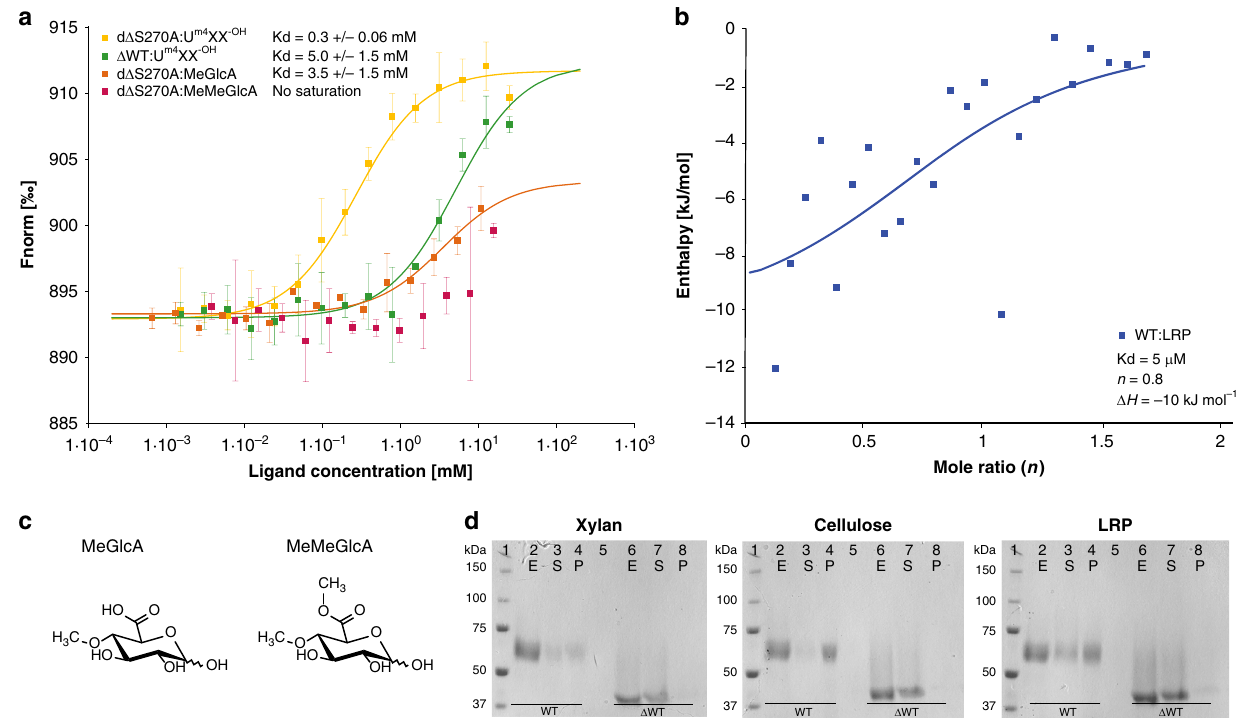
Fig. 5 Af fi nity for natural substrates or derived soluble fragments. a Ligand-binding af fi nities of soluble ligands to various Cu GE variants as determined by LabelFree microscale thermophoresis (MST). Legend details and estimated K d -values are listed in the panel and error bars represents standard deviation. b ITC enthalpogram of the interaction between WT Cu GE and the enzyme ’ s natural insoluble lignin-rich substrate (LRP) at 5 °C. The titration curve is depicted as a function of the molar ratio ( n ) between enzyme and the calculated concentration of 4- O -methyl-glucuronoyl in the assay. The latter is an estimation of the concentration of recognition sites in the substrate. c Chemical structures of small ligands 4- O -methyl- D -glucuronic acid (MeGlcA) and the methyl ester of 4- O -methyl- D -glucuronic acid (MeMeGlcA) used in MST measurements of binding af fi nity in a . The structures are depicted to illustrate that equilibrium between the α - and β -anomers exists in an aqueous solution. d Qualitative SDS-PAGE-based “ pull-down ” assay illustrating the effect of CBM1 on the binding to the insoluble biopolymers xylan, cellulose and LRP, respectively. 1: Molecular size ladder, 2: WT without substrate, 3: Supernatant after binding between WT Cu GE and insoluble substrate, 4: Pellet after binding between WT Cu GE and insoluble substrate, 5: Insoluble substrate without enzyme, 6: Δ WT Cu GE without substrate, 7: Supernatant after binding between Δ WT Cu GE and insoluble substrate, 8: Pellet after binding between Δ WT Cu GE and insoluble substrate. The description of lane content applies to all three gel pictures. Source data for panel a , b , and d are provided as a Source Data fi